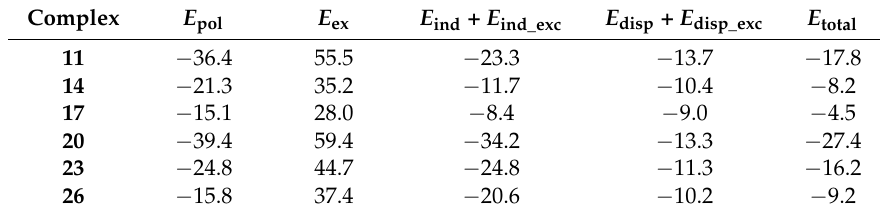
Table 3. DFT-SAPT partition energies (electrostatic, E pol ; exchange, E ex ; induction E ind + E ind_exc ; dispersion, E disp + E disp_exc and total E total ) computed for cation– π and regium– π Ag complexes in kcal · mol − 1